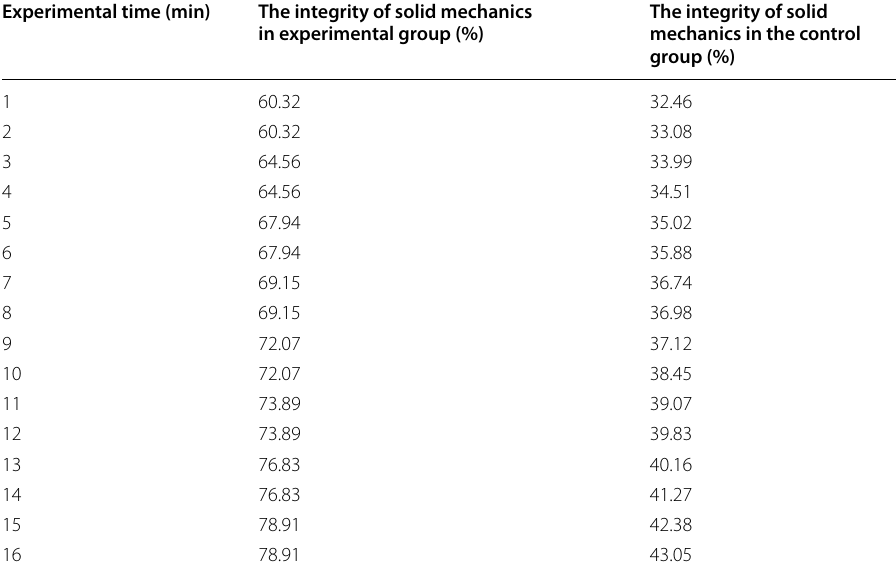
Table 4 Comparison of integrity of solid mechanics computing (operation status of low mechanical parameter)